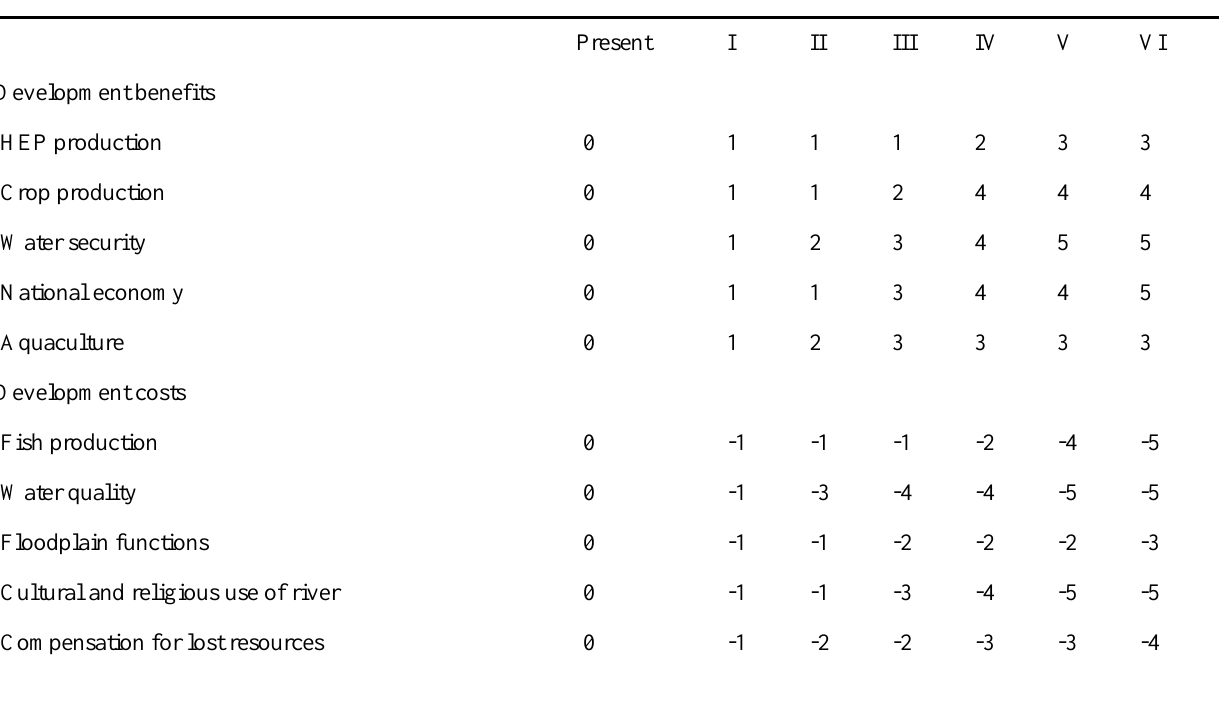
Table 10 . Hypothetical example of the matrix of information that could be developed for each part of a river basin. The indicators would differ from river to river, and the numbers used here are merely to illustrate possible trends in indicator status. The numbers do not constitute a scoring system; rather, the specialists’ reports should be referred to for the detail represented by each numbered cell. Decisions should be based on this underlying information. Ratings of change: 1= negligible change from present; 2 = low change; 3 = moderate change; 4 = high change; 5 = very high change. Negative values indicate either that the river ecosystem is moving away from its natural state, i.e. degrading, or a compensation/mitigation